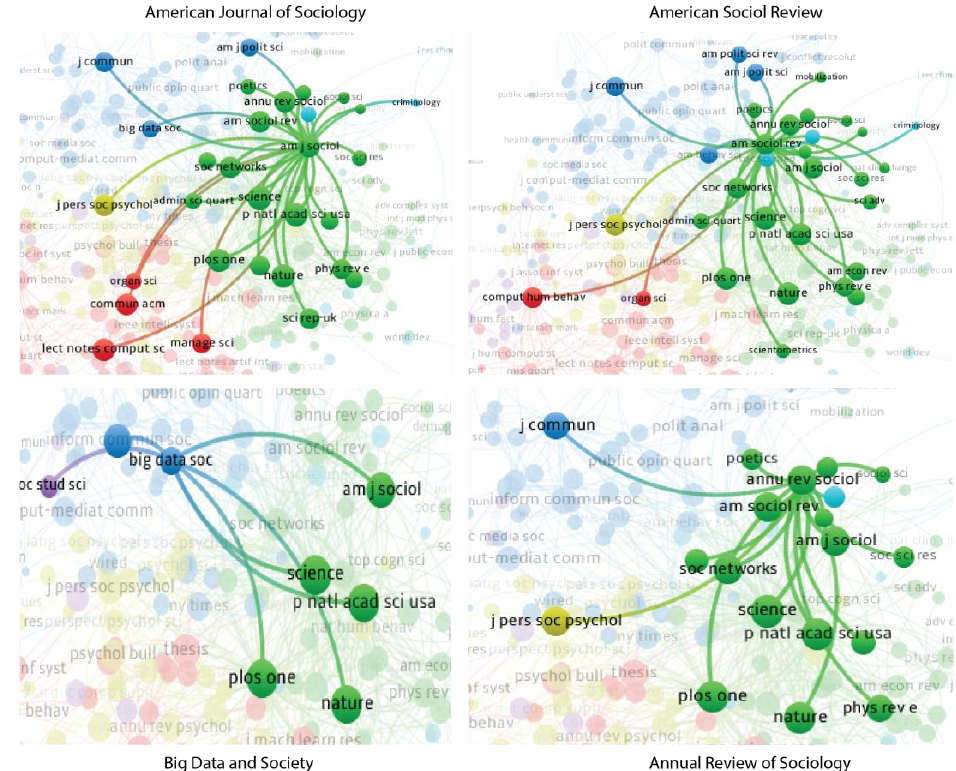
Figure 6. A focused view for American Journal of Sociology, American Sociological Review, Big Data & Society and Annual Review of Sociology.